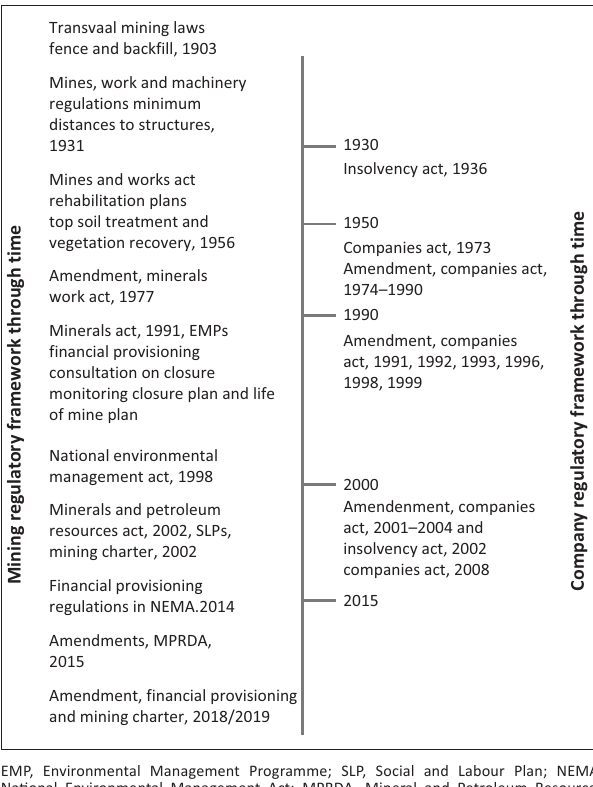
FIGURE 5: Evolution of mining versus company